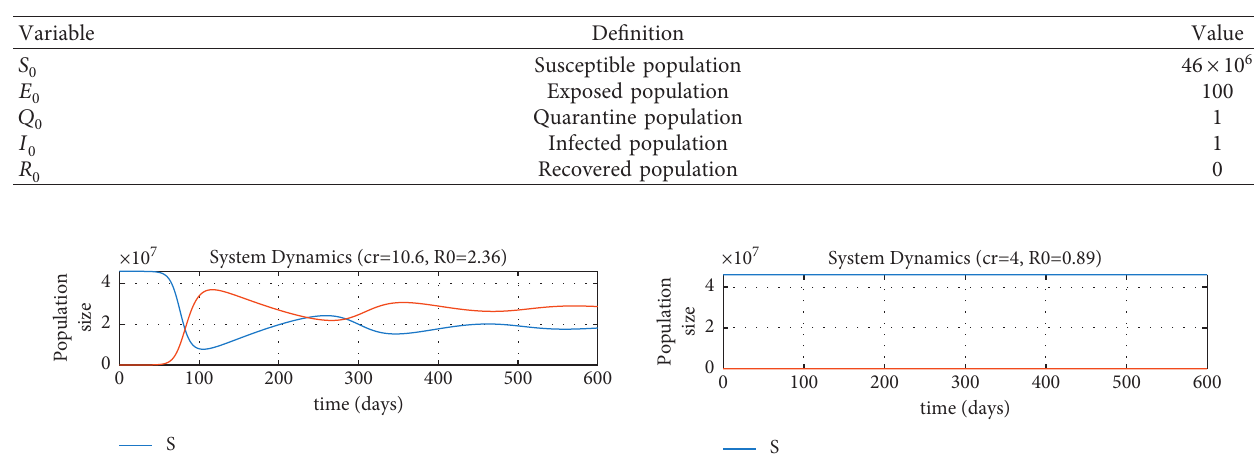
� 10.6 and R � 2.360 (a) and c r 0